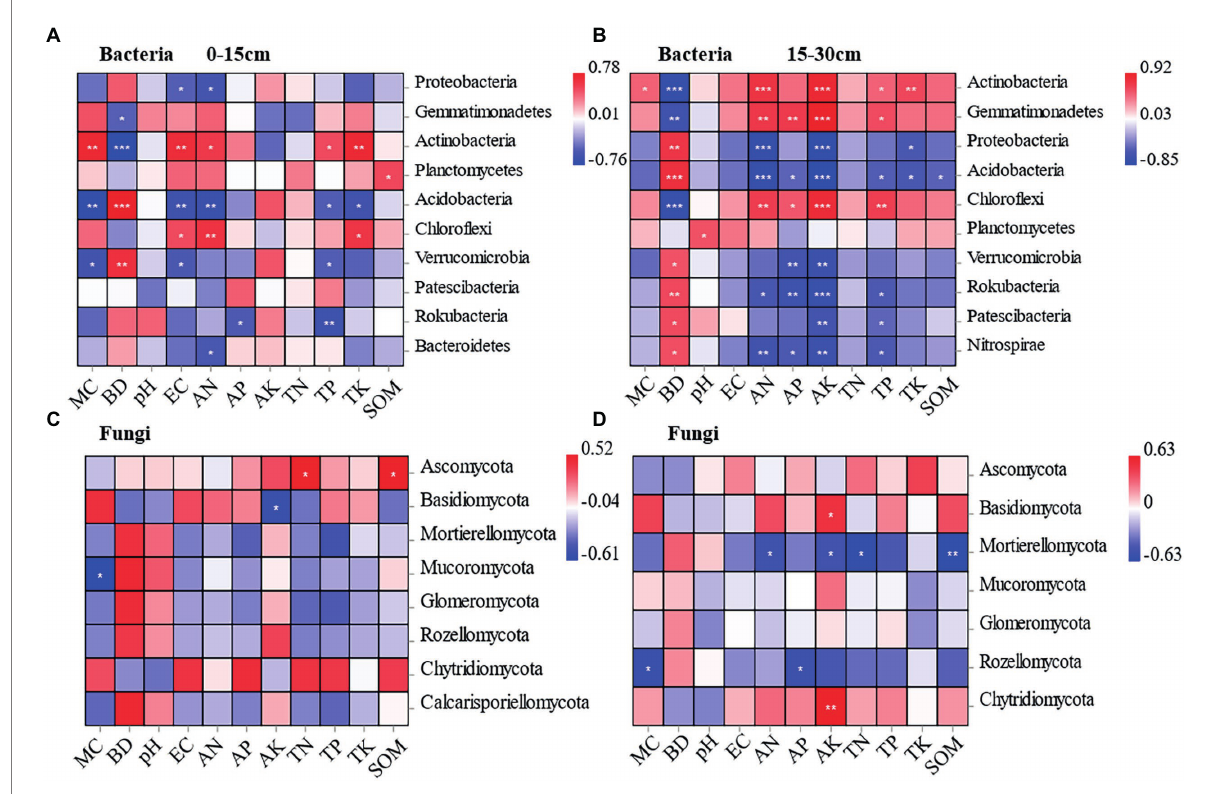
FIGURE 6 Pearson correlation between soil bacteria and soil physicochemical properties at the depths of 0-15 cm and 15-30 cm under different treatments (A, B) . Pearson correlation between soil fungal and soil physicochemical properties at the depths of 0-15 cm and 15-30 cm under different treatments (C, D)